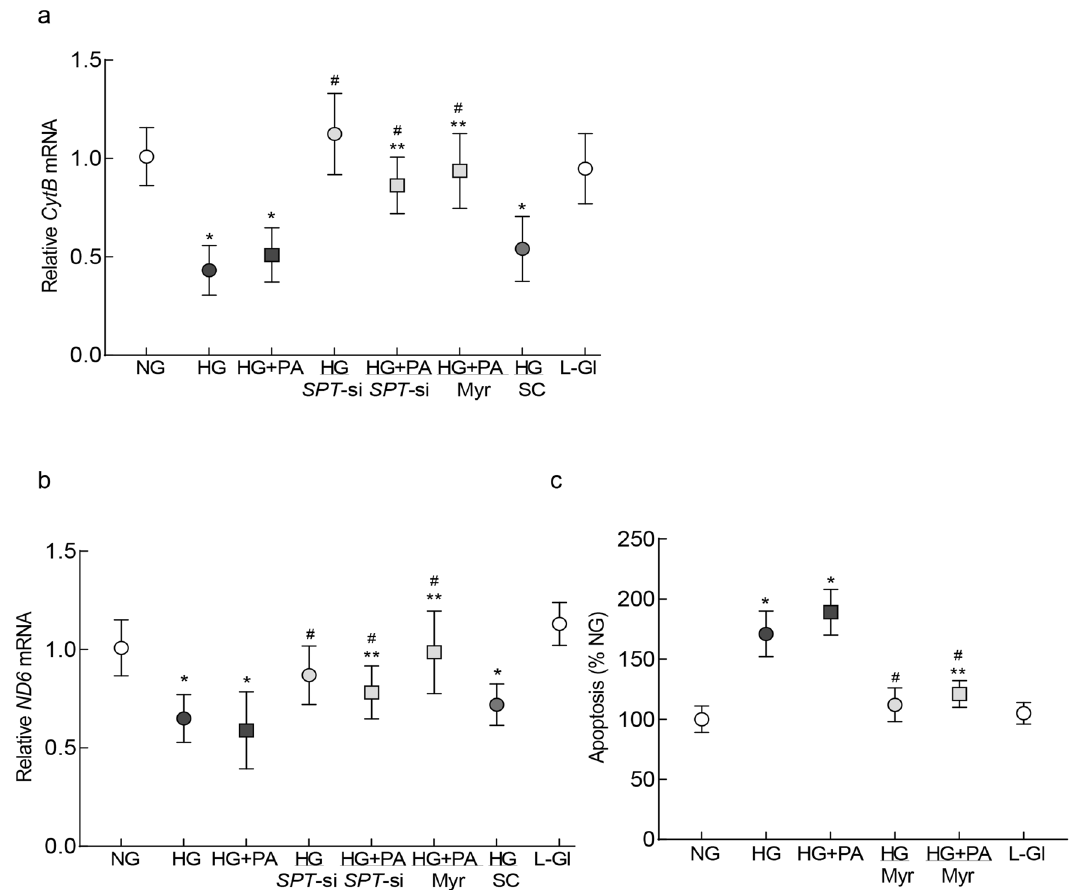
Figure 3. Regulation of SPT and mitochondrial damage-cell apoptosis. Damage of mtDNA was determined by quantifying relative mRNA levels of mtDNA-encoded ( a ) CytB and ( b ) ND6 by qRT-PCR, β-actin was employed as a housekeeping gene. ( c ) Cell death was determined using a Cell Death Detection ELISA PLUS kit. Each measurement was made in duplicate, and the values are represented as mean ± SD from 3 or more